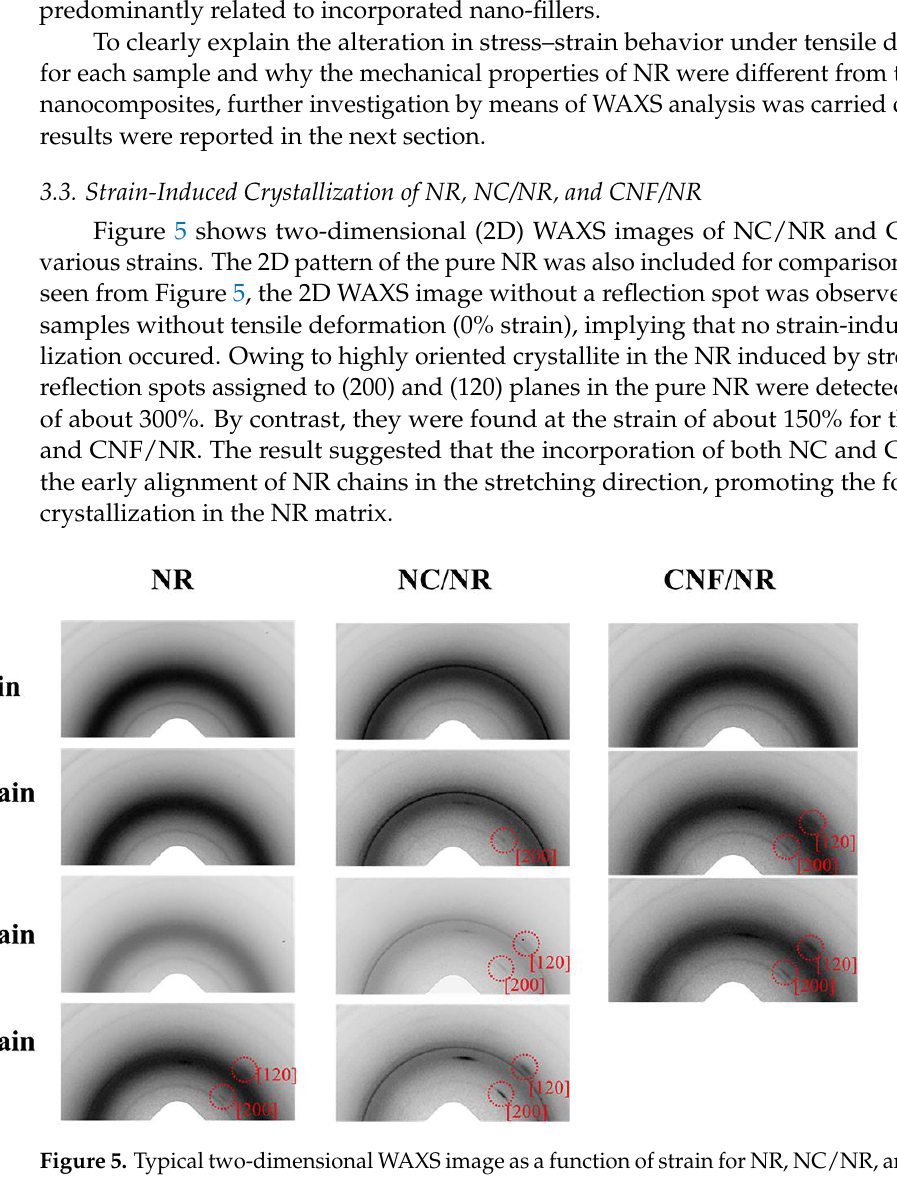
Figure 5. Typical two-dimensional WAXS image as a function of strain for NR, NC/NR, and